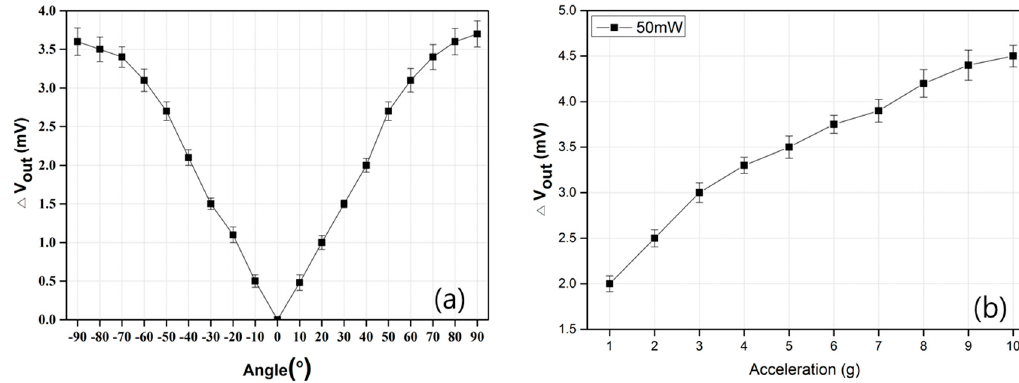
Figure 3. The output voltage of the accelerometer as a function of ( a ) tilting angles and ( b ) accelerations.